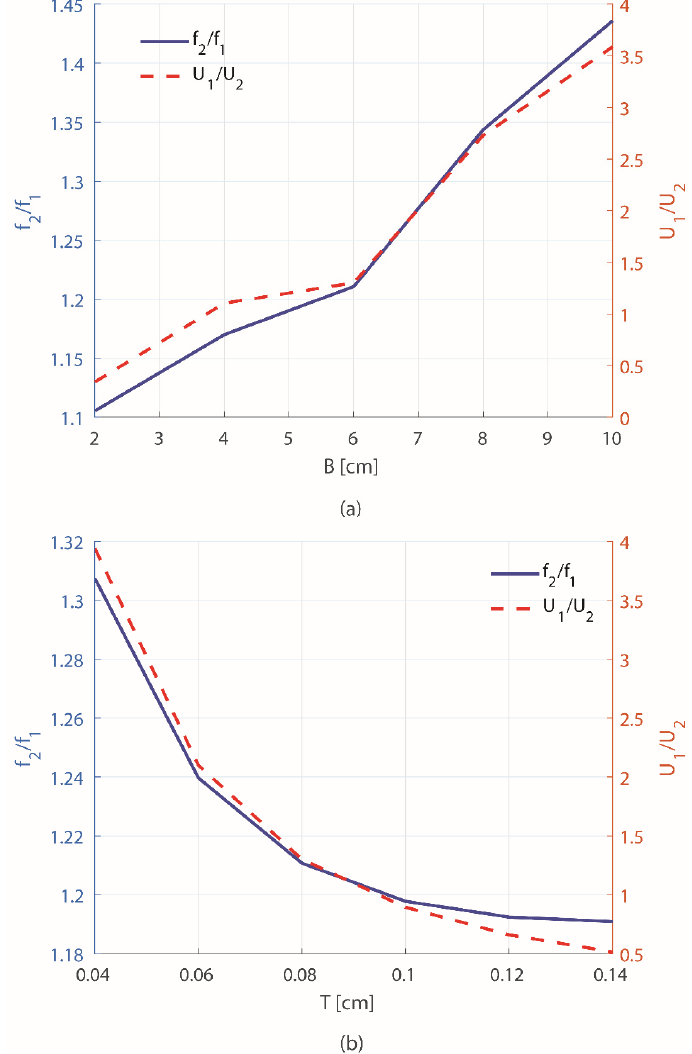
/ ff and the vibration amplitude ratio Figure 16. The frequency ratio f 2 / f 1 and the vibration amplitude ratio U 1 / U 2 as functions of the Figure 16. The frequency ratio 12 length of the longer edge B ( a ), and the thickness T ( b length of the longer edge B ( a ), and the thickness T ( b ).